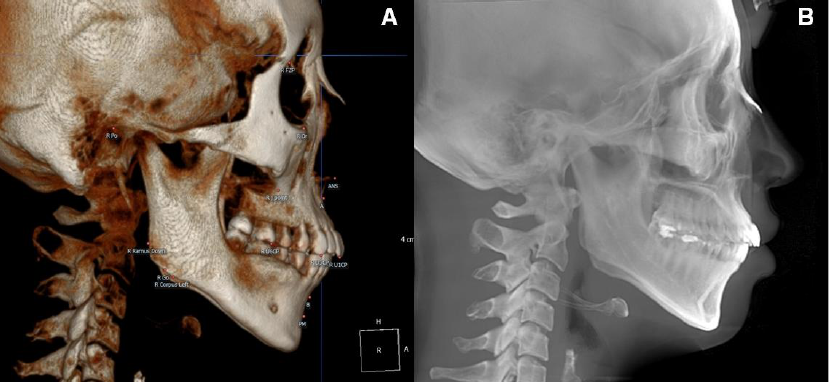
Figure 1. ( A ), CBCT 3D image view. The image was oriented along the Frankfort horizontal plane in reference to the right porion, right orbitale, and left orbitale. ( B ), CBCT-synthesized lateral cephalogram was constructed in accordance with orientation.